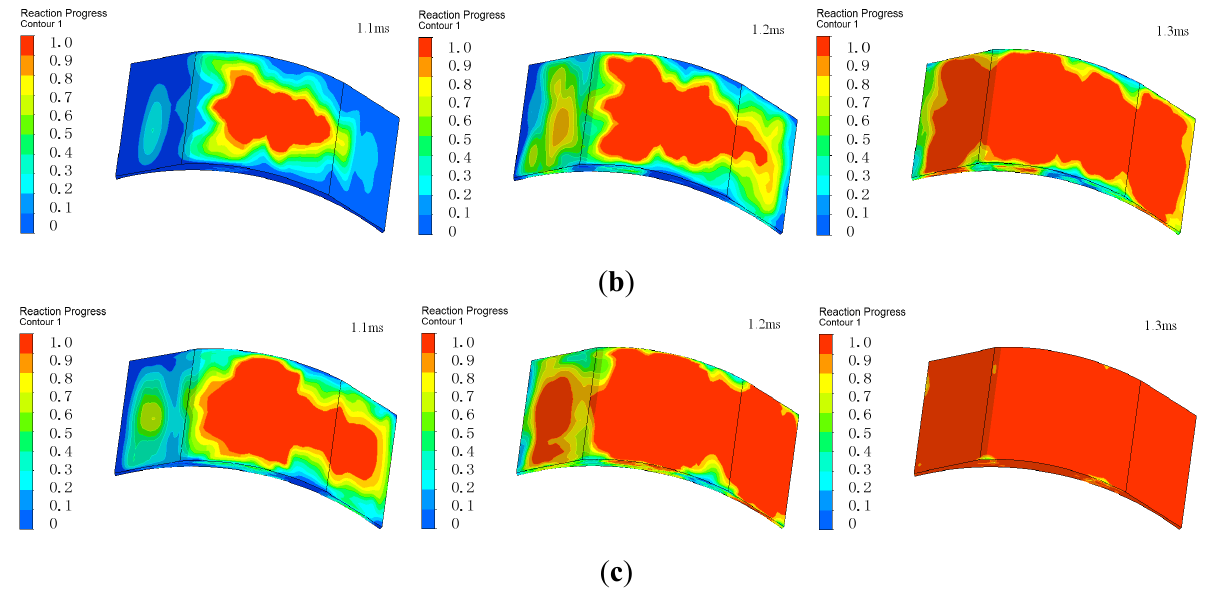
Figure 13. ( a ) Reaction process at temperature 580 K; ( b ) Reaction process at temperature 600 K; ( c ) Reaction process at temperature 620